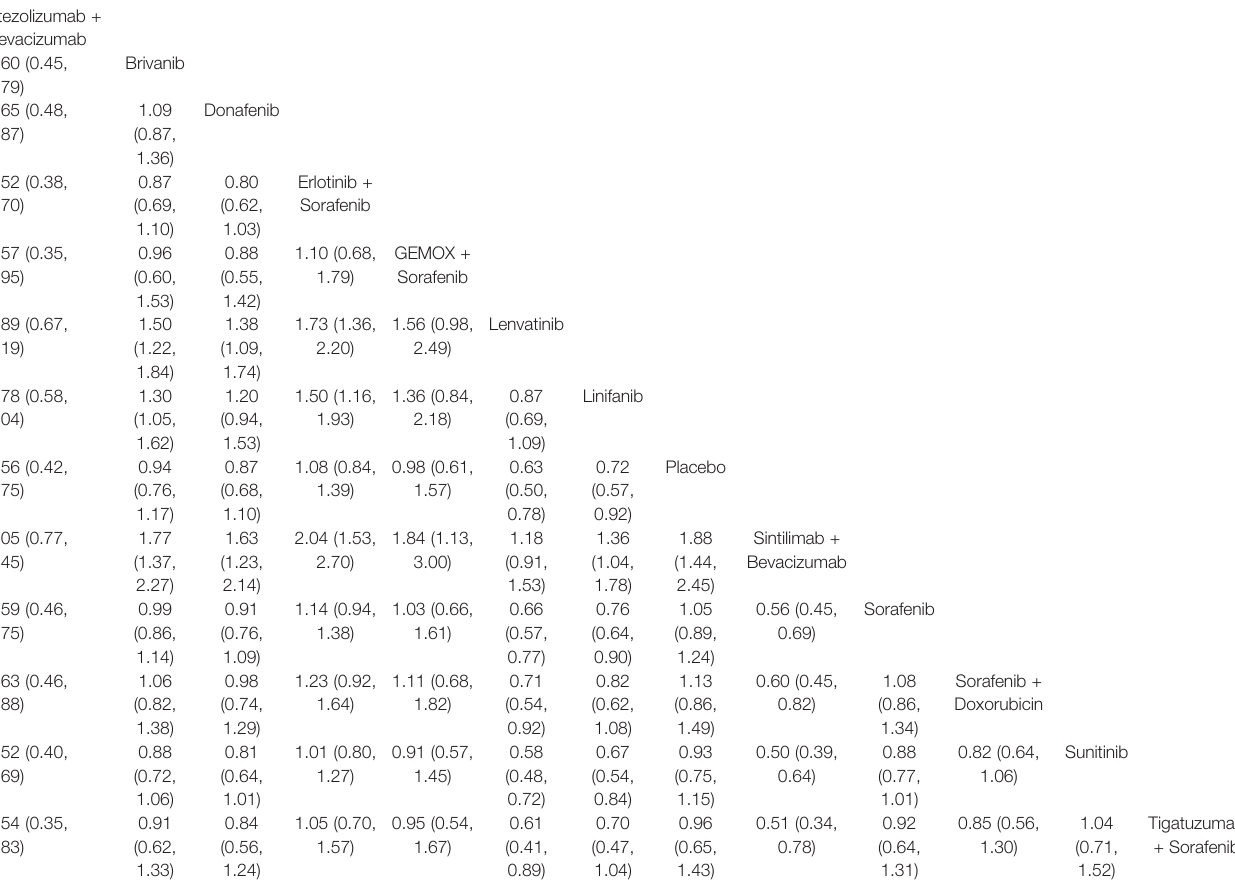
TABLE 3 | Network meta-analyses for PFS. Atezolizumab +